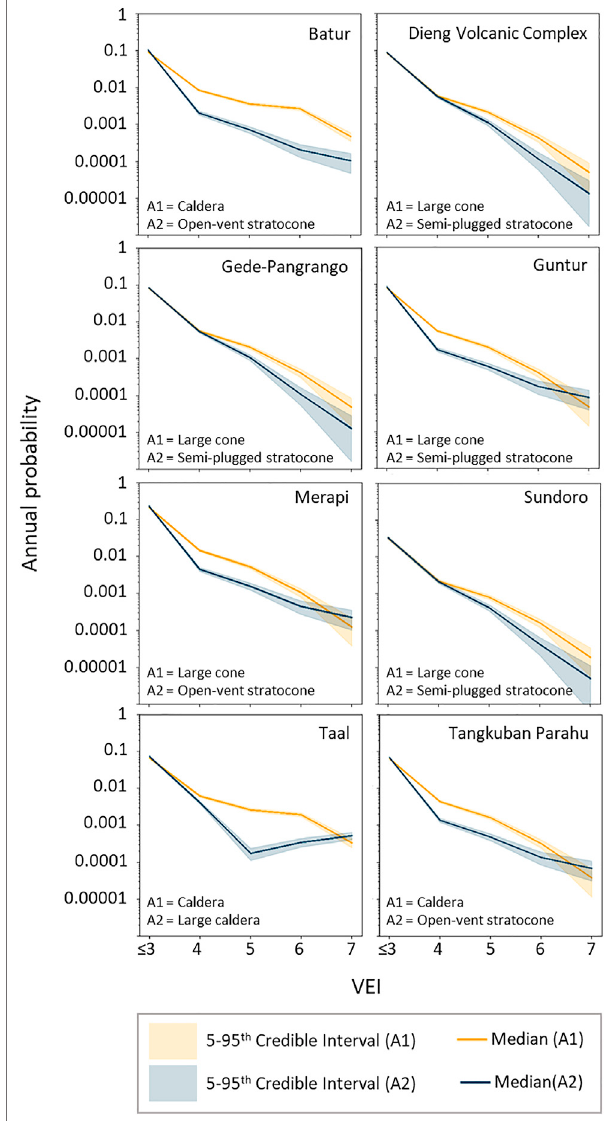
FIGURE 9 | Comparing Bayesian update frequency-magnitude estimates using two different analogue models. Considerable differences between the two analogue systems can be observed. Note: VEI are discrete data presented as continuous data to emphasize the relationship between VEI and annual